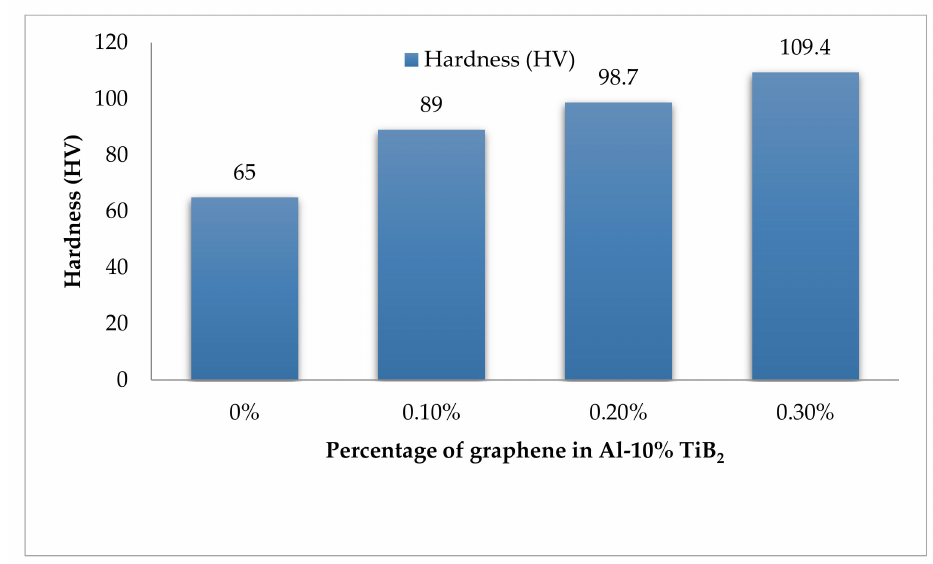
Figure 13. Hardness results.